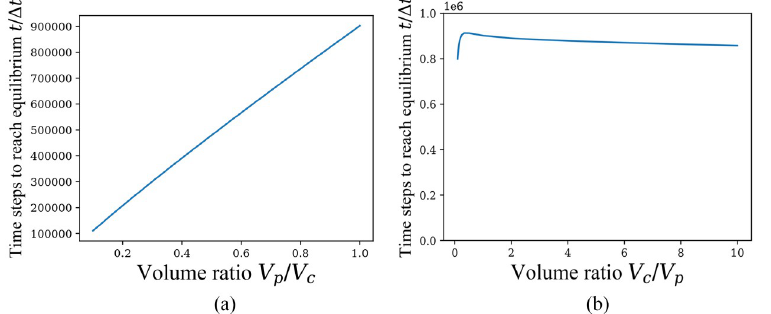
Fig 5. Time to reach equilibrium for ξ = 0 when V c or V p is fixed and the other one varies. Time used to reach equilbrium state with the unit of Δ t when the initial concentrations of H + and lactose are fixed in periplasm and cytoplasm, which has the initial conditions n = V ¼ C = 40 ; N L = V ¼ 3 C = 40 , ξ = 0. (a) V N L 0 0 p c p c